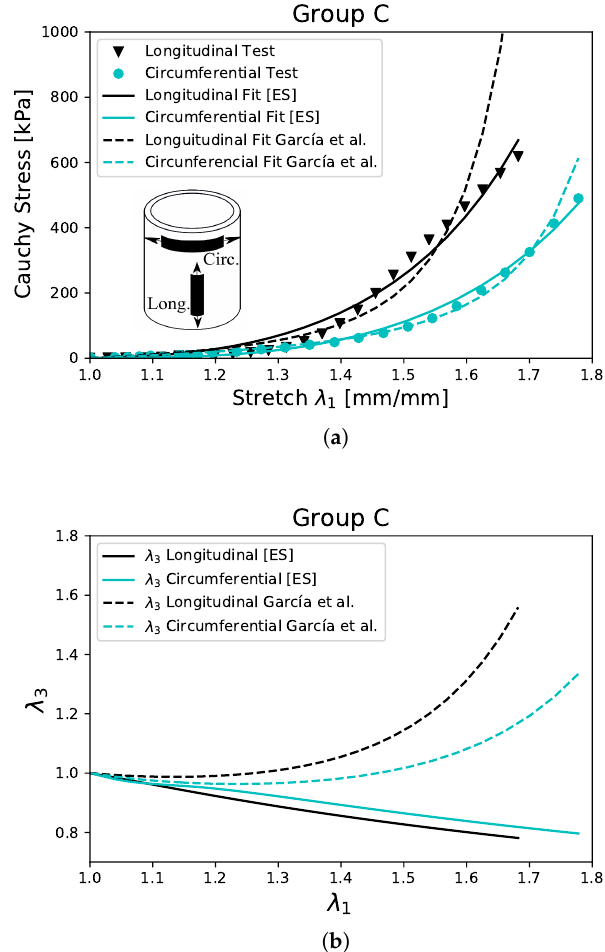
Figure 11. Adjustments of the experimental data of unixial traction with the GHO model and the transverse stretch λ 3 corresponding to each of the adjustments. ( a ) Tensile test; ( b ) Transversal Stretch λ 3